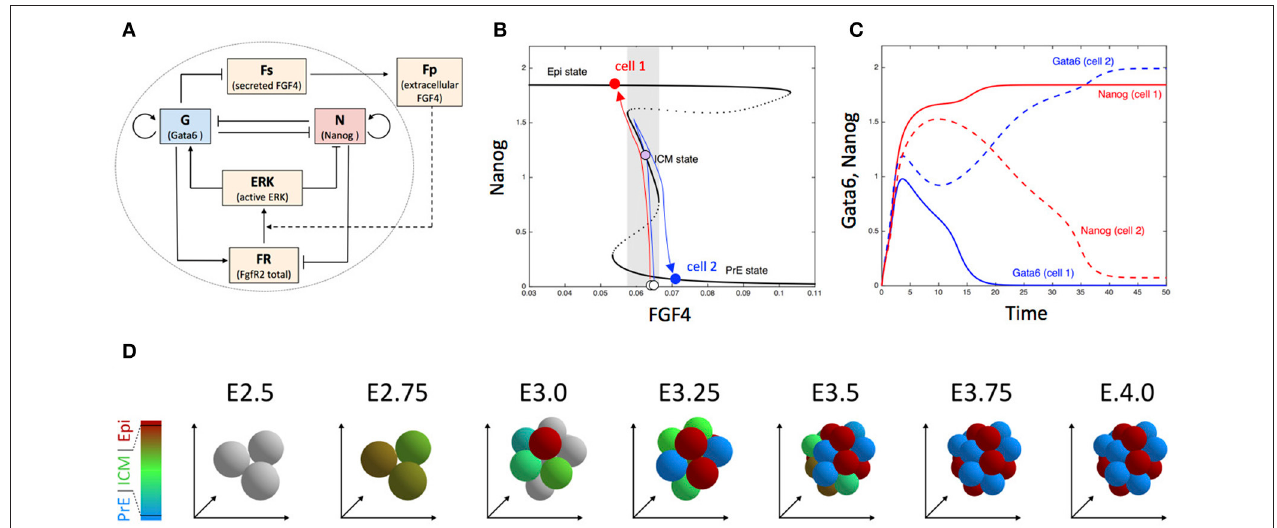
FIGURE 5 | Dynamics of embryonic cell fate determination. (A) Scheme of the gene regulatory network. (B) Bifurcation diagram showing the steady state of Nanog as a function of FGF4. The blue and red arrows depict the trajectory of two cells (for more details, see De Mot et al., 2016). (C) Time evolution of Nanog and Gata6 in the two-cell model. (D) Snapshots showing the simulated the evolution of embryonic cells from the 3 inner cells stage in the 3D model including cell division. Outer cells (trophectoderm) are not considered. Cells are colored according to the proportion of Nanog (red) and Gata6 (blue), with gray indicating blastomers with very low Nanog and Gata6 concentrations. See Tosenberger et al. (2017) for